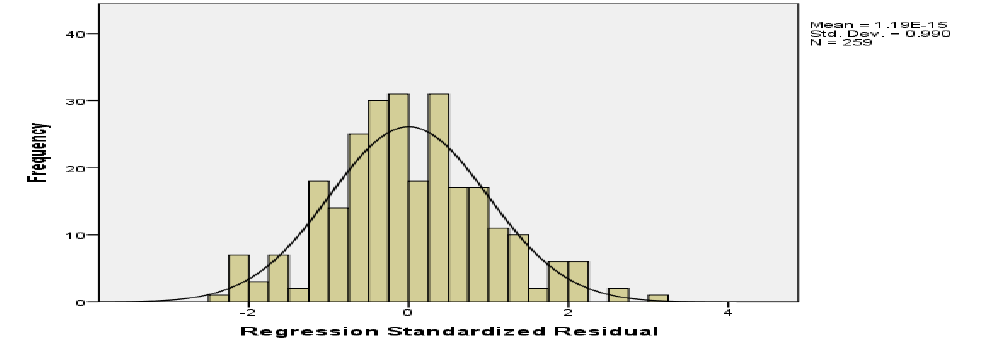
Fig. 3 . Histogram – Dependent Variable